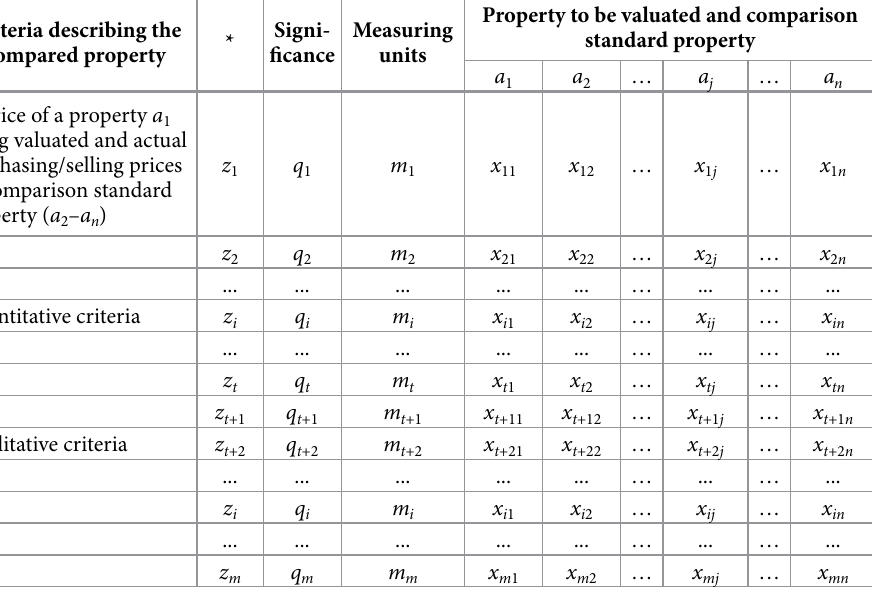
table 3. A grouped decision making matrix for property multiple criteria analysis criteria describing the compared property